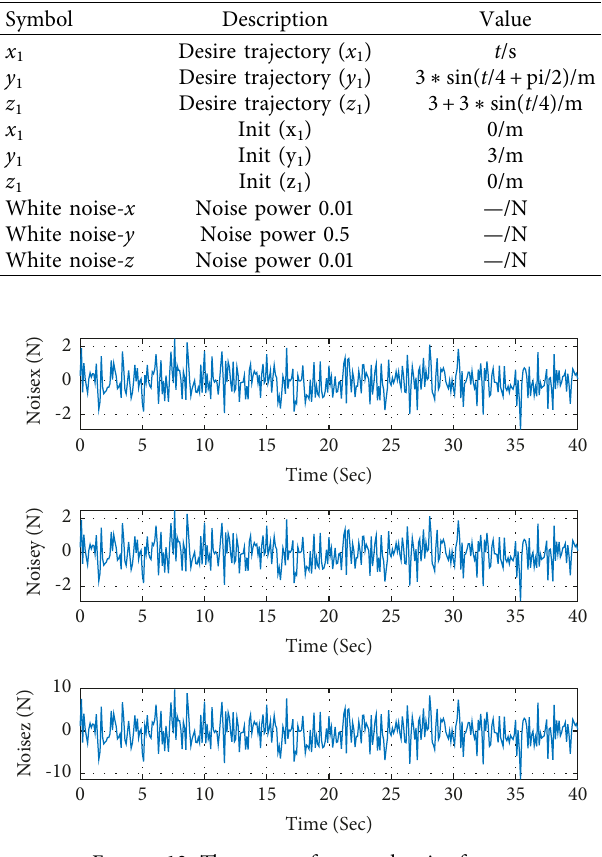
Figure 13: The curve of external noise